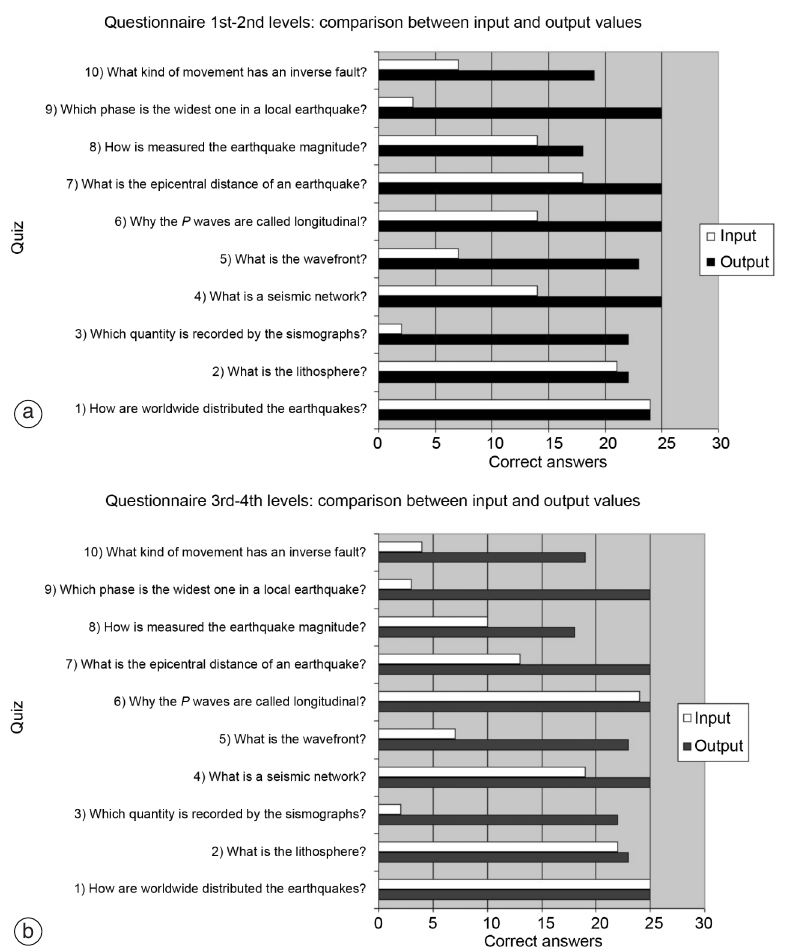
Fig. 5a,b. A comparison between before and after values of a questionaire administered at the beginning and the end of the experiment for 1st and 2nd leveles (a) and 3rd and 4th levels